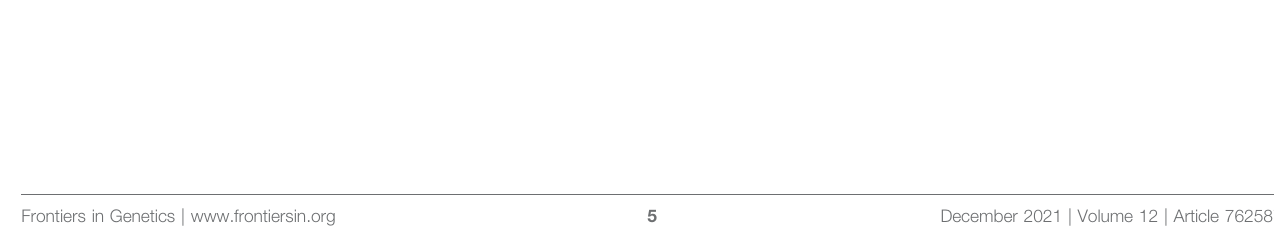
Frontiers in Genetics |